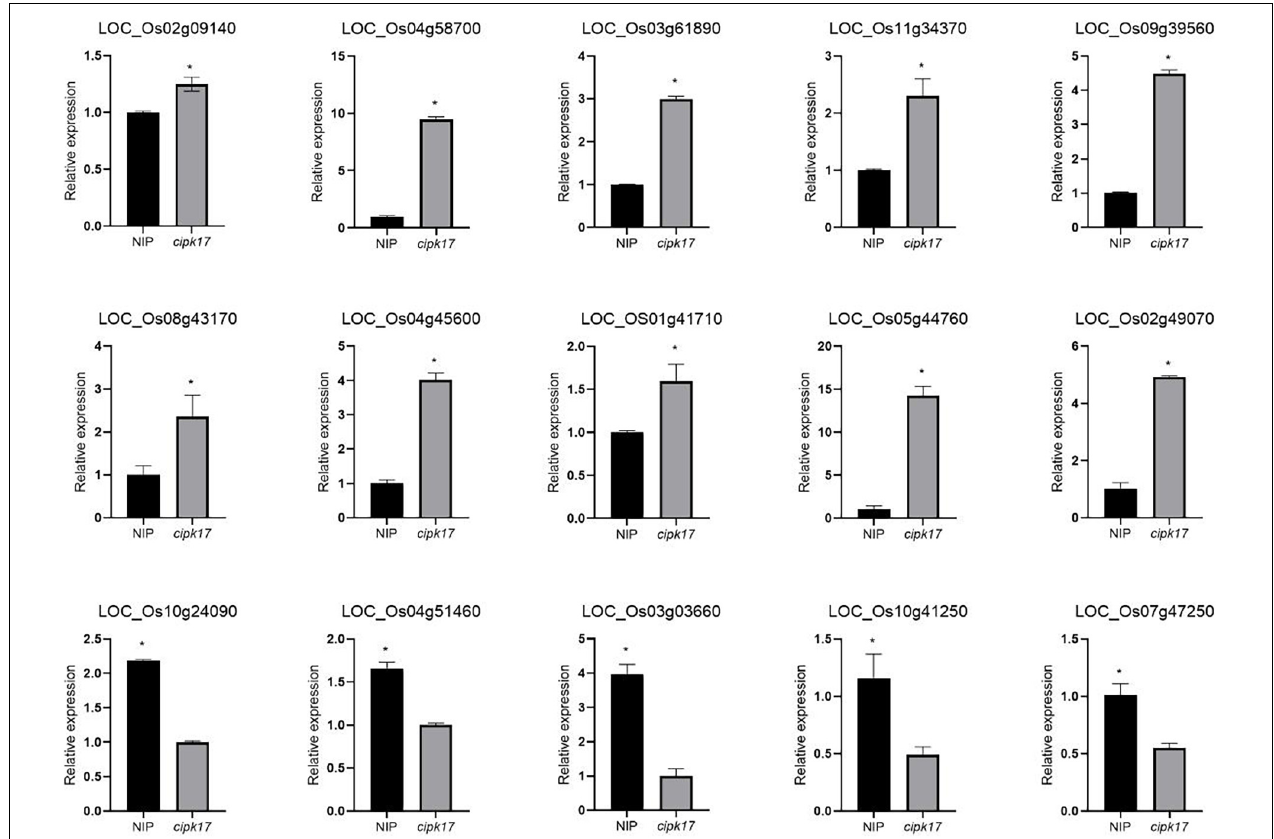
FIGURE 5 | Fluorescence quantitative expression analysis of differential genes. Asterisks above the bar indicate that there were significant differences between NIP and cipk17 material at p <